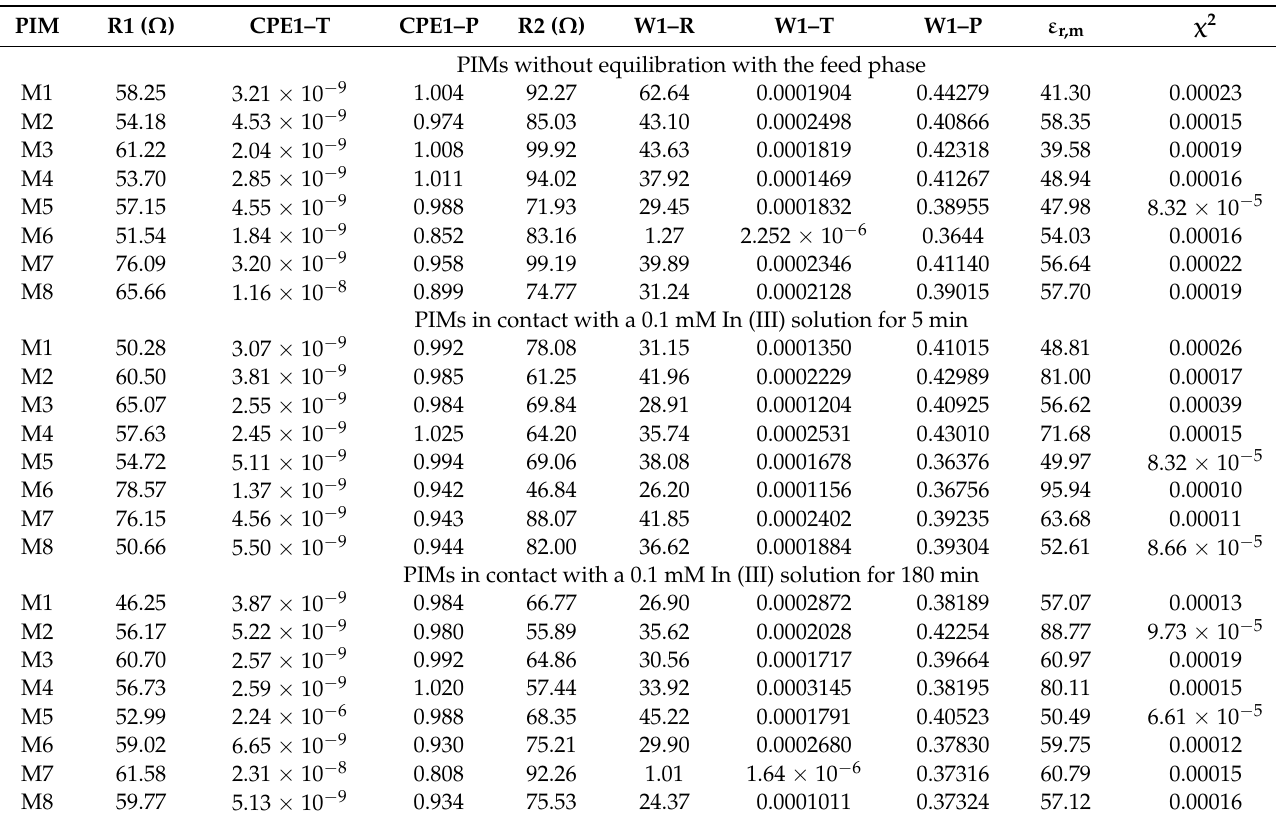
Table 8. Results of the EIS characterization of the